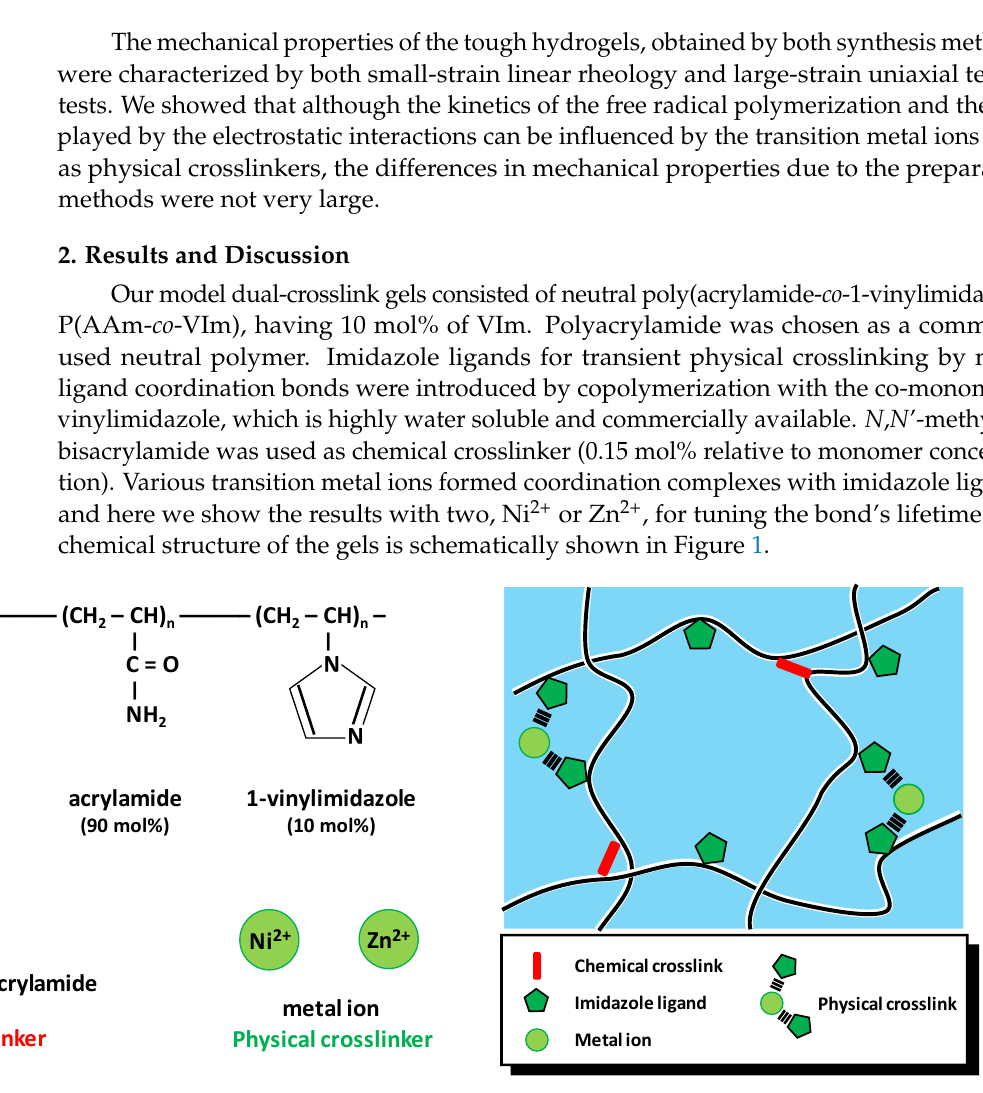
Figure 1. Structure of P(AAm- co -VIm) – M 2+ dual-crosslink gels (M: Ni or Zn).